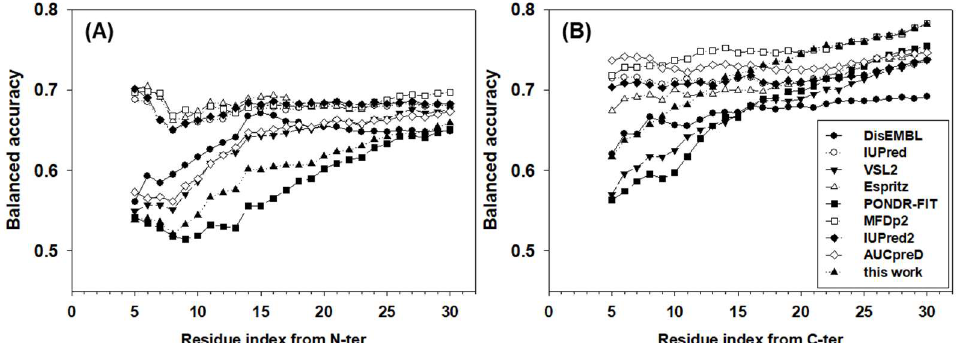
Figure 4. Balanced accuracy of ( A ) N-terminal and ( B ) C-terminal residues. The x -axis shows the distance from the first (N-terminal) or the last (C-terminal) residue. The analysis starts at the fifth residue on both N- and C-termini. The y -axis shows the value of the balanced accuracy.